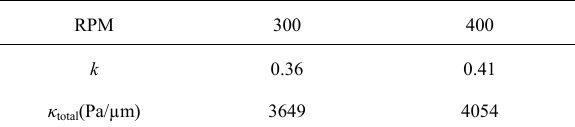
Fig. 16 Measured smoothing factor SF vs. initial magnitude ɛ ini and linear fitting results for 300-RPM and 400-RPM tool speed V. Table 4 Slope of SF function k and compressive tool stiffness κ total .